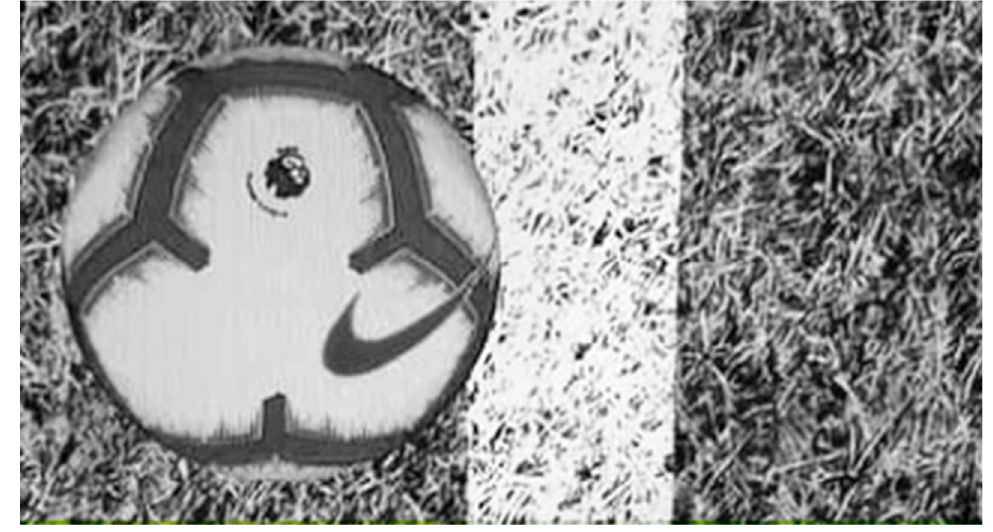
Figure 2. Goal line technology reconstruction.